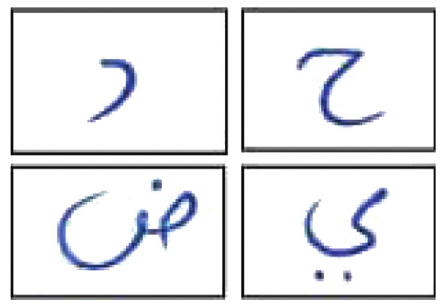
Figure 2: Character images before preprocessing steps.